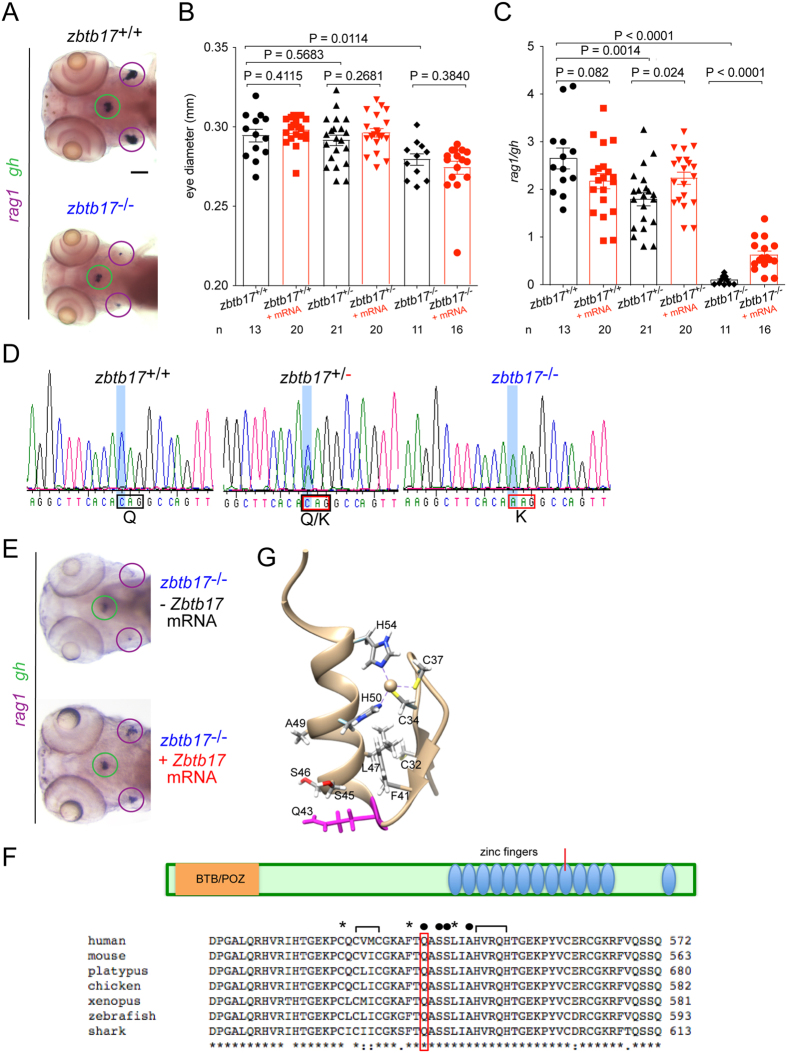
Impaired T cell development in fish homozygous for a missense mutation in zbtb17.(A) Representative microphotographs of wild-type (top panel) and homozygous mutant (bottom panel) zebrafish embryos hybridized with probes specific for rag1 (purple circle) and gh (green circle) at 5 dpf. (B) Eye diameter (means ± s.e.m.) for the three different zbtb17 genotypes (numbers of fish indicated) without (black bars) and with injection of mouse Zbtb17 wild-type mRNA (mRNA) determined at 4 dpf. (C) Thymopoietic indices (means ± s.e.m.) for the three different zbtb17 genotypes without (black bars) and with injection of mouse Zbtb17 wild-type mRNA (mRNA) determined at 4 dpf. (D) Representative sequence traces covering part of exon 10 sequences of wild-type fish (left panel), heterozygotes (middle panel) and homozygous mutants (right panel). The C > A transversion occurs at nucleotide position 1684 of ENSDARG00000074548 (http://www.ensembl.org/Danio_rerio/Transcript/Summary?db=core;g=ENSDARG00000074548;r=23:24525127-24540083;t=ENSDART00000114840). (E) Representative microphotographs of zbtb17 mutant embryos after injection of mouse Zbtb17 mRNA hybridized with probes specific for rag1 and gh at 96 hpf. The thymic rudiments (marked by expression of rag1) are encircled in purple, the hypophysis (marked by expression of gh) is encircled in green. (F) Schematic of the ZBTB17 proteins, indicating the position of known domains, including the 12 zinc finger modules. Below, an alignment of partial protein sequences of vertebrate ZBTB17 proteins around the critical region of the ninth zinc finger (marked in schematic) is shown. The presumptive zinc-coordinating (brackets), DNA-contacting (solid circles) and hydrophobic (asterisks) amino acid residues are marked. Source sequences: human, H. sapiens, Genbank accession number NP_001274532.1; mouse, M. musculus, Genbank accession number NP_033567.2; platypus, Ornithorhynchus anatinus, Genbank accession number XP_003429656.1; chicken, G. gallus, Genbank accession number NP_001263229.1; xenopus, X. tropicalis, Genbank accession number NP_001011141.2; zebrafish, D. rerio, Genbank accession number XP_003201251.1; shark, C. milii, Genbank accession number XP_007905152.1. (G) Structure of the ninth zinc finger of the mouse Zbtb17 protein (source code 2LVT); the mutated Q43 residue is indicated in purple. Scale bar, 100 μm.